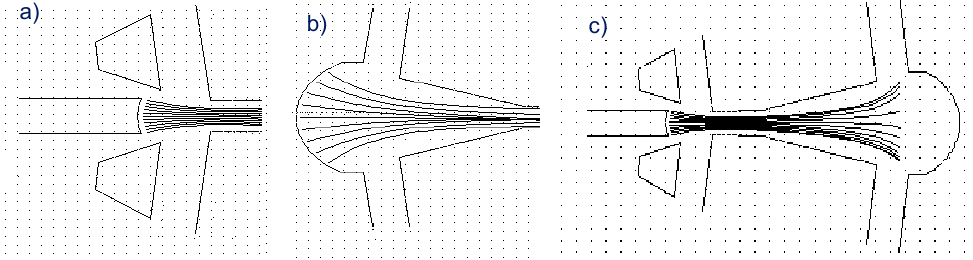
Figure 17. Synthesis of a functional resotrode cell according to the "gun-anti-gun" scheme: ( a ) cathode–anode part (gun), ( b ) collector-output part (anti-gun), ( c ) full synthesized cell